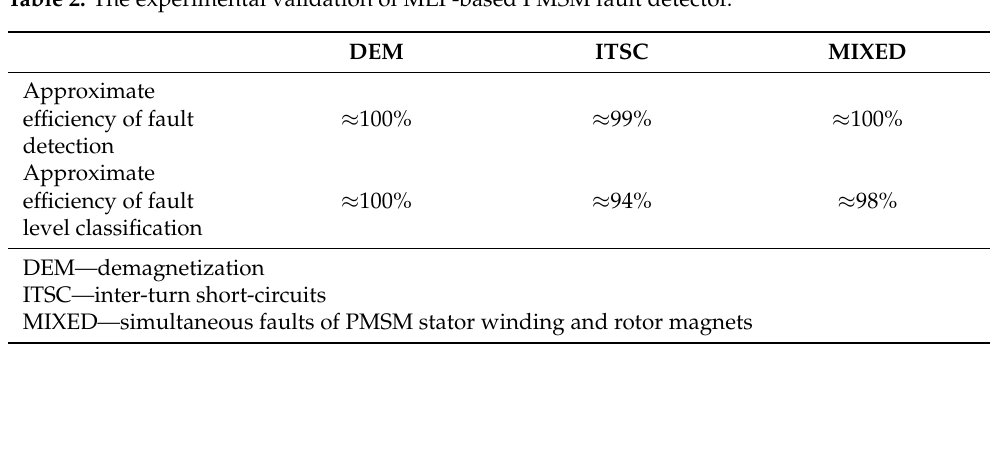
Table 2. The experimental validation of MLP-based PMSM fault